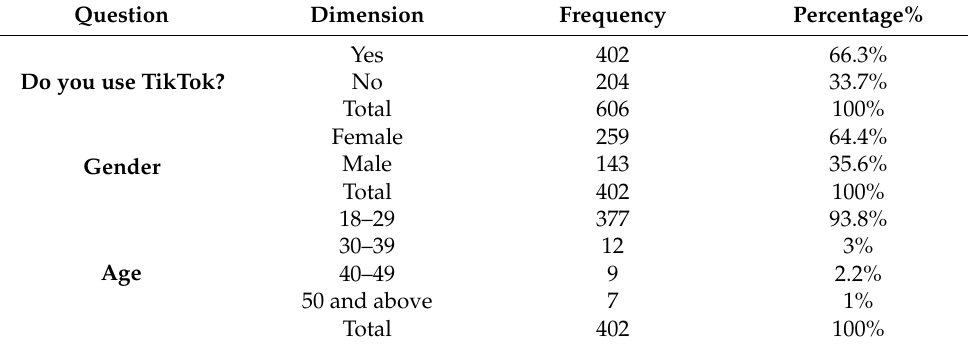
Table 1. Demographics Analysis of